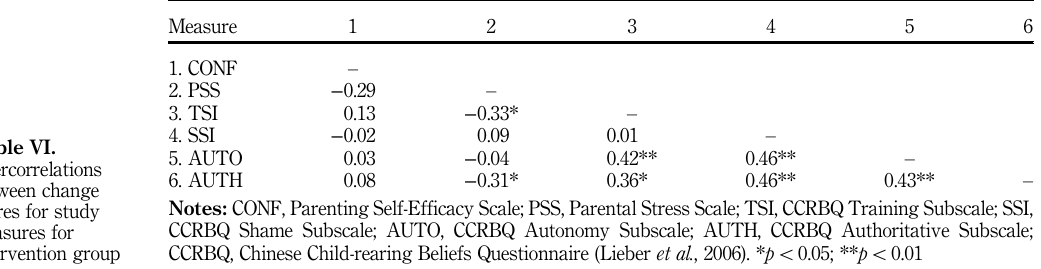
Table VI. Intercorrelations between change scores for study measures for intervention